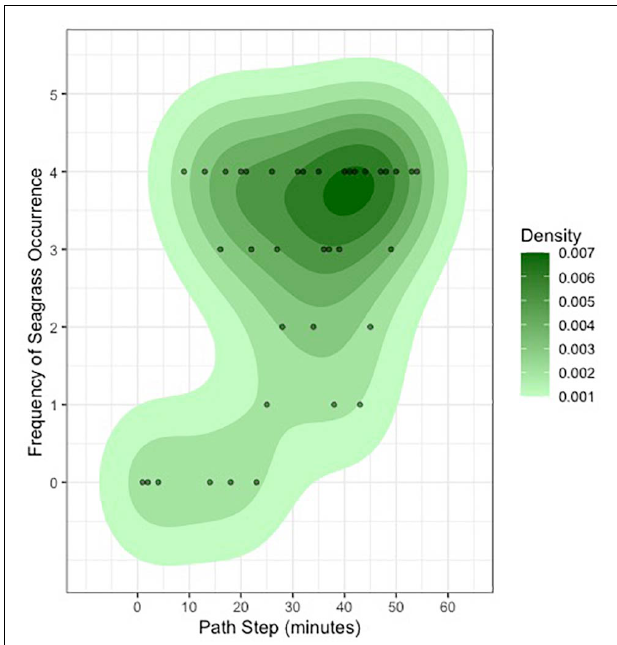
FIGURE 4 | Estimates of seagrass density, derived from scoring all 224 habitat assessments in 360 degrees over the course of the entire track, highlighting the ability for marine megafauna tagged with 360-degree cameras to provide detailed information on seafloor